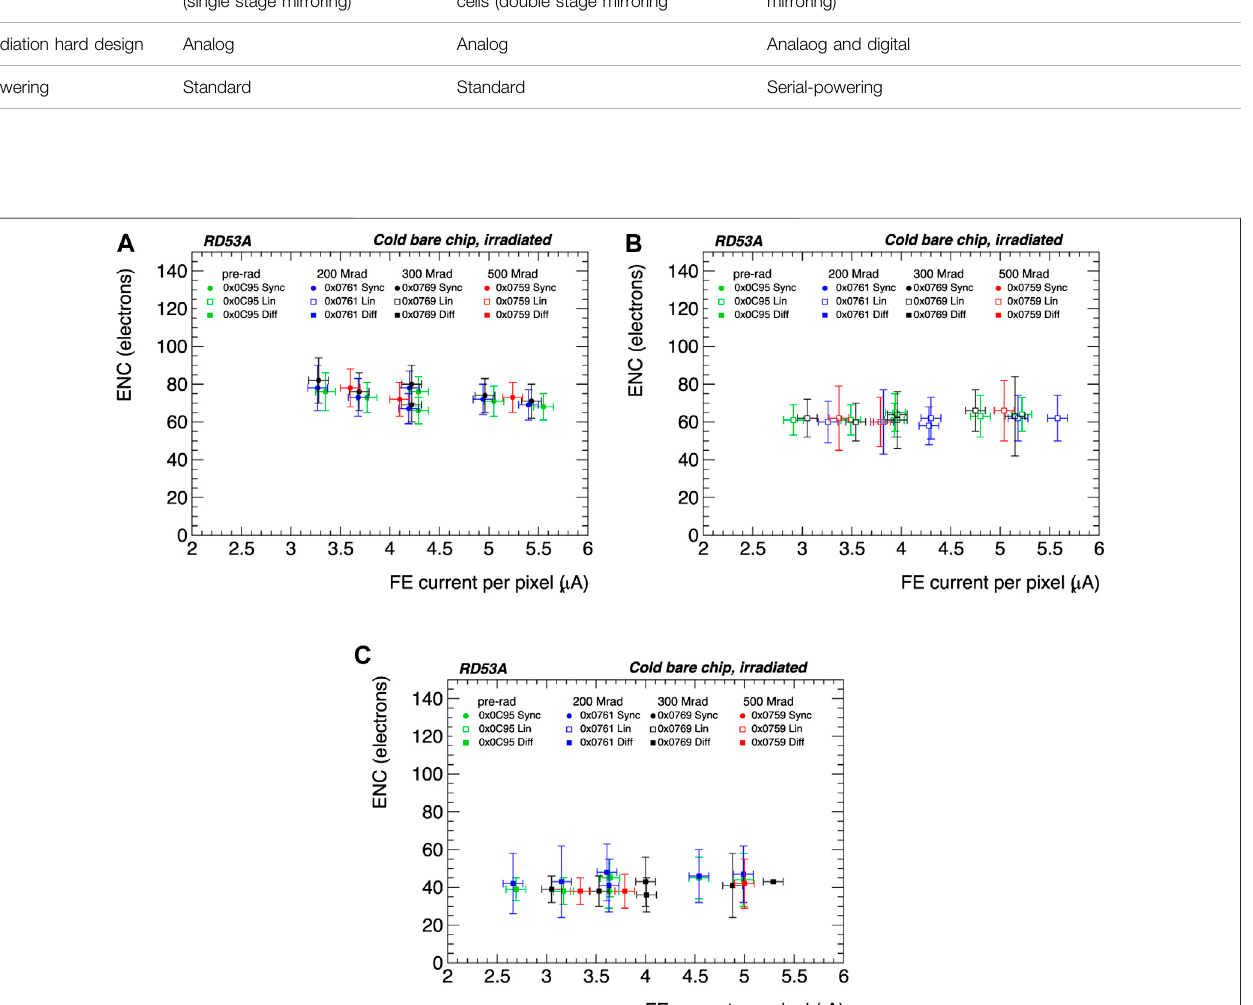
Frontiers in Physics |